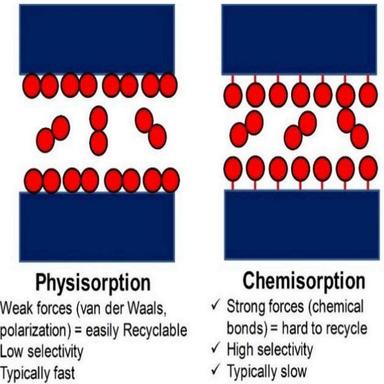
Types of sorption based separation/purification: chemisorption vs. physisorption.